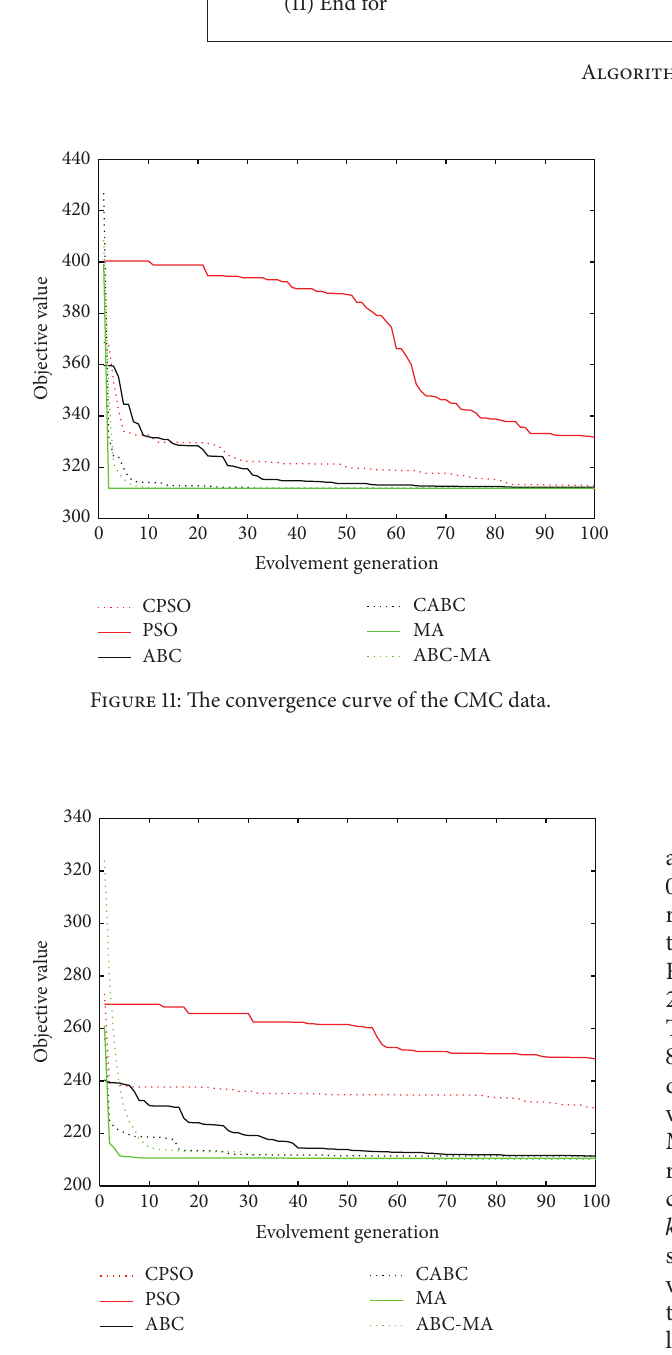
Figure 12: The convergence curve of the seeds data.